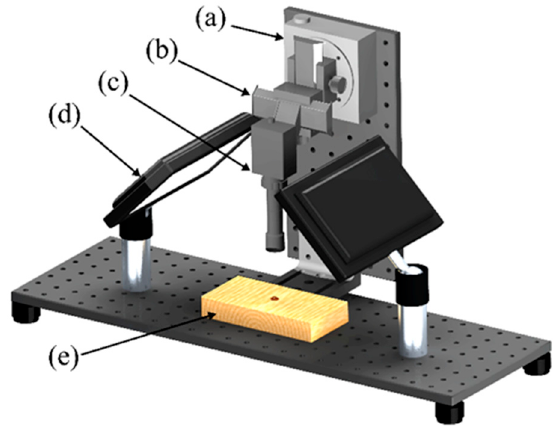
Figure 4. Experimental facility: ( a ) rotation stage, ( b ) xz -axis macro positioning stage, ( c ) CCD camera, ( d ) LED light panel, and ( e ) wood substrate.